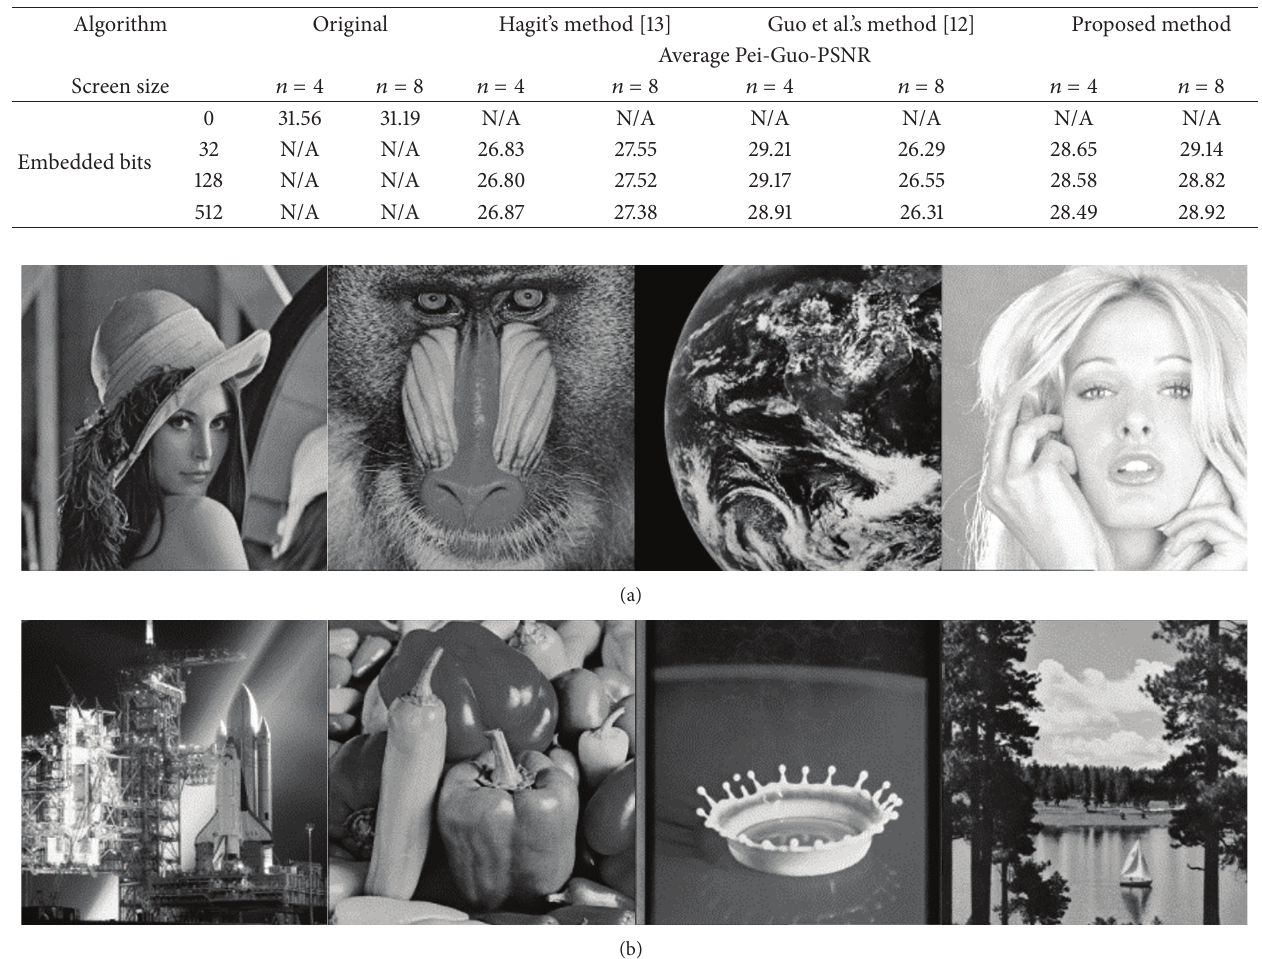
Table 3: Quality comparisons of various algorithms using Pei-Guo-PSNR [12].